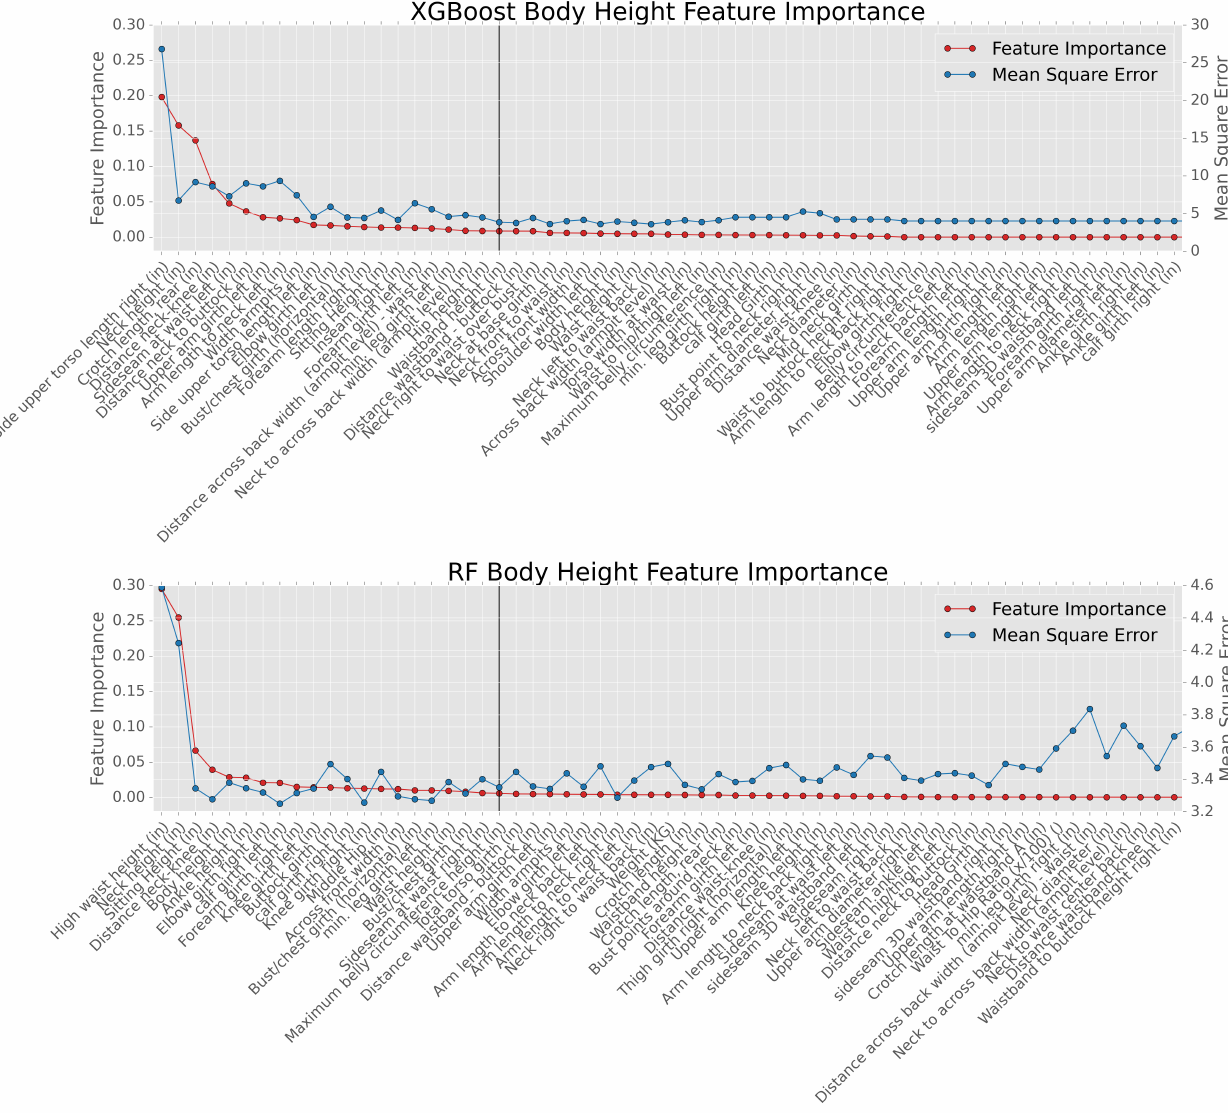
Figure 7. Illustration of the relationship between feature importance and